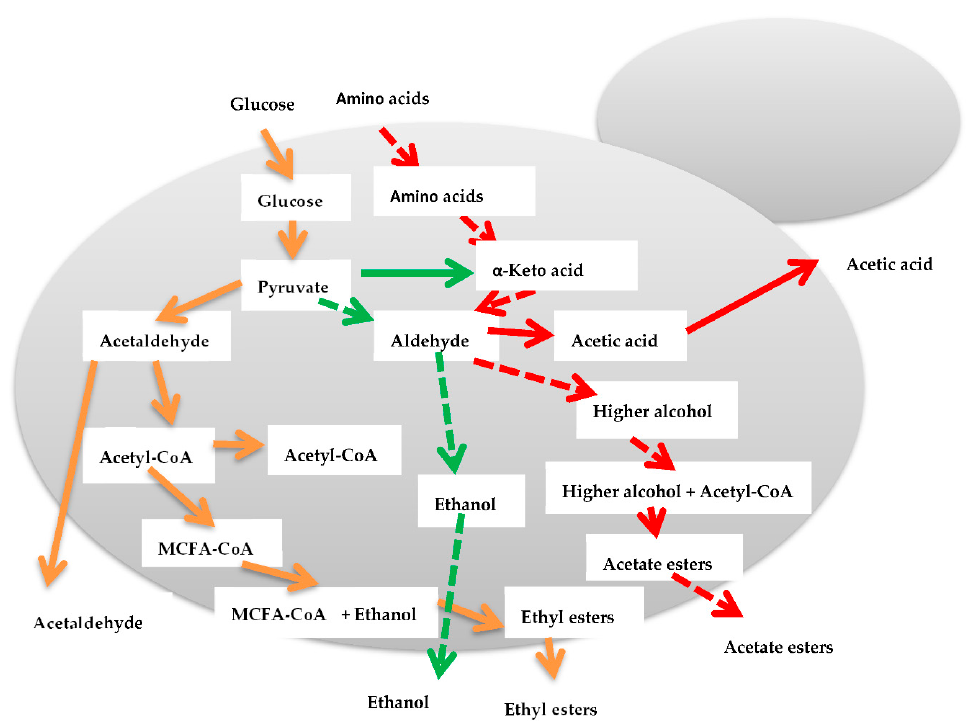
Figure 5. Formation of esters and other volatile compounds by S . cerevisiae through metabolism of glucose and amino acids. Table 4. Volatile compounds produced in marula fruit wine by spontaneous and starter cultures fermentation